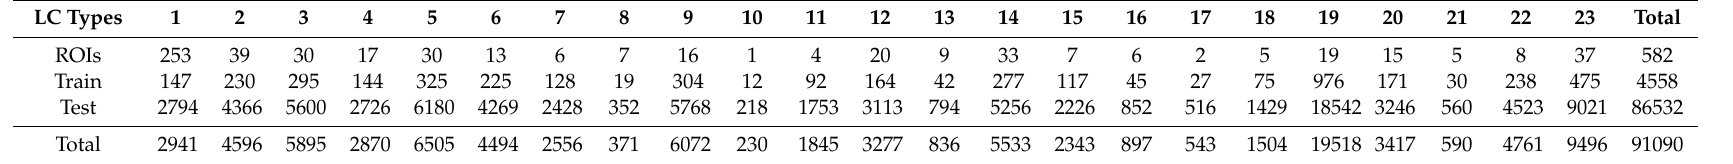
Table 2. Details of the land cover types in the training and validation samples in the test